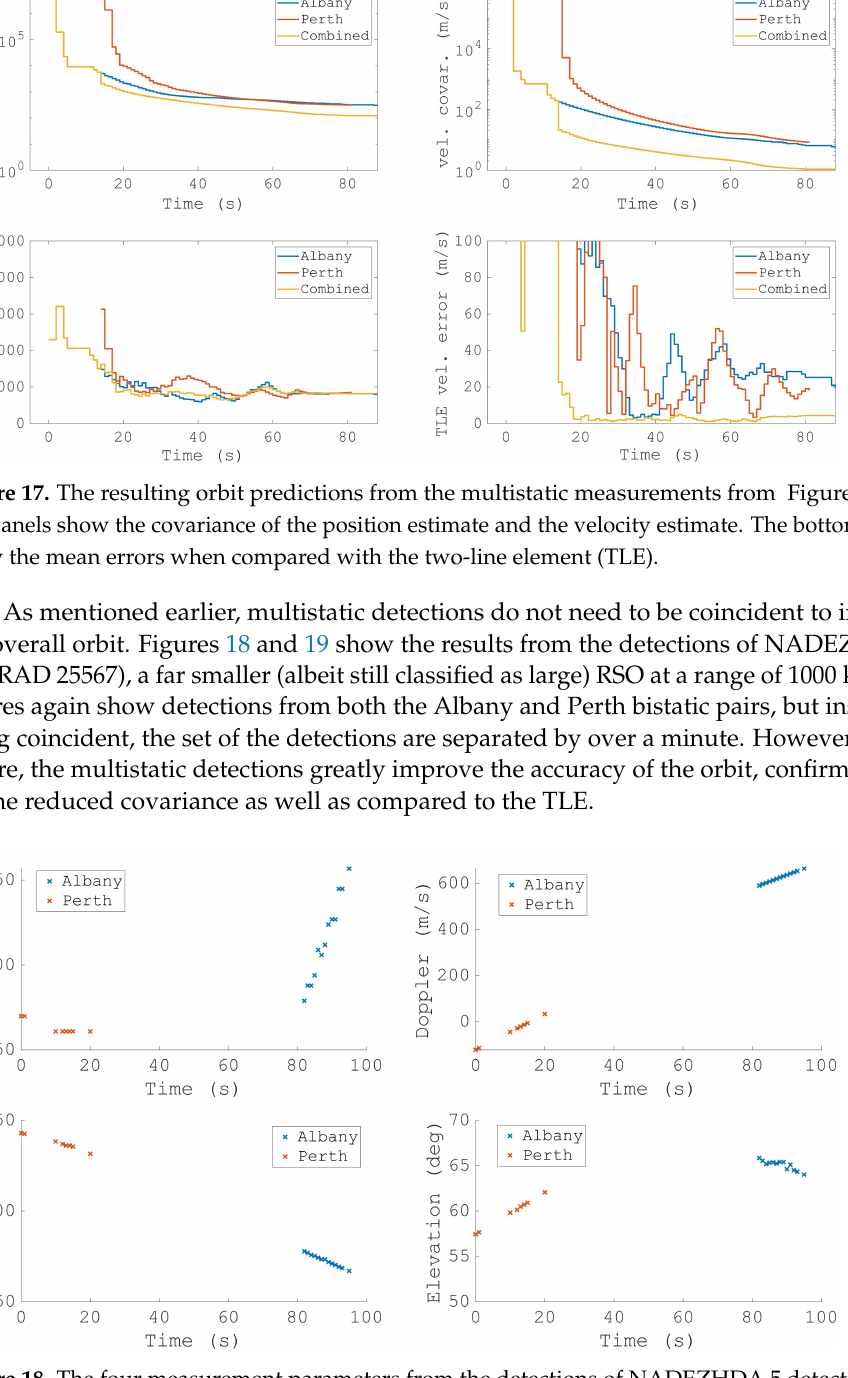
Figure 18. The four measurement parameters from the detections of NADEZHDA 5 detected using FM transmitters in both Albany and